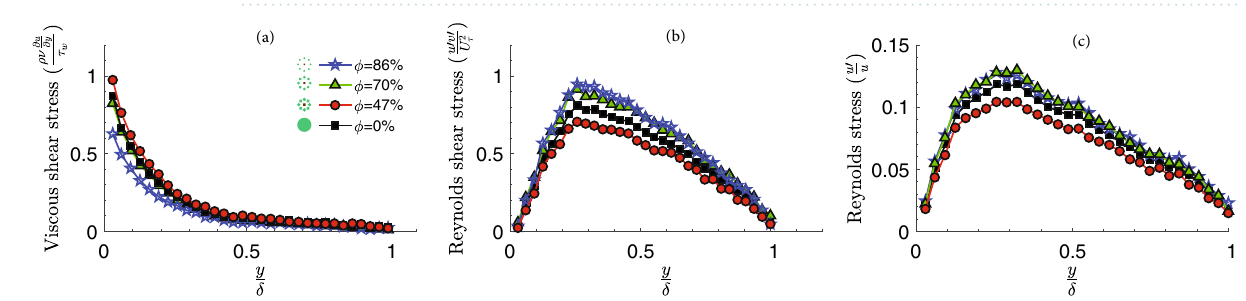
Figure 7. Spatially-averaged of flow parameters changing immediately behind the models. ( a ) Viscous shear stress changes with distance from the bed normalized by the boundary layer thickness ( δ ). ( b ) Variations of Reynolds shear stress normalized by shear velocity ( U τ ). ( c ) Reynolds stress variations from the bed. It was observed that the total shear stress was constant across the layer and equal to the wall shear stress ( τ w